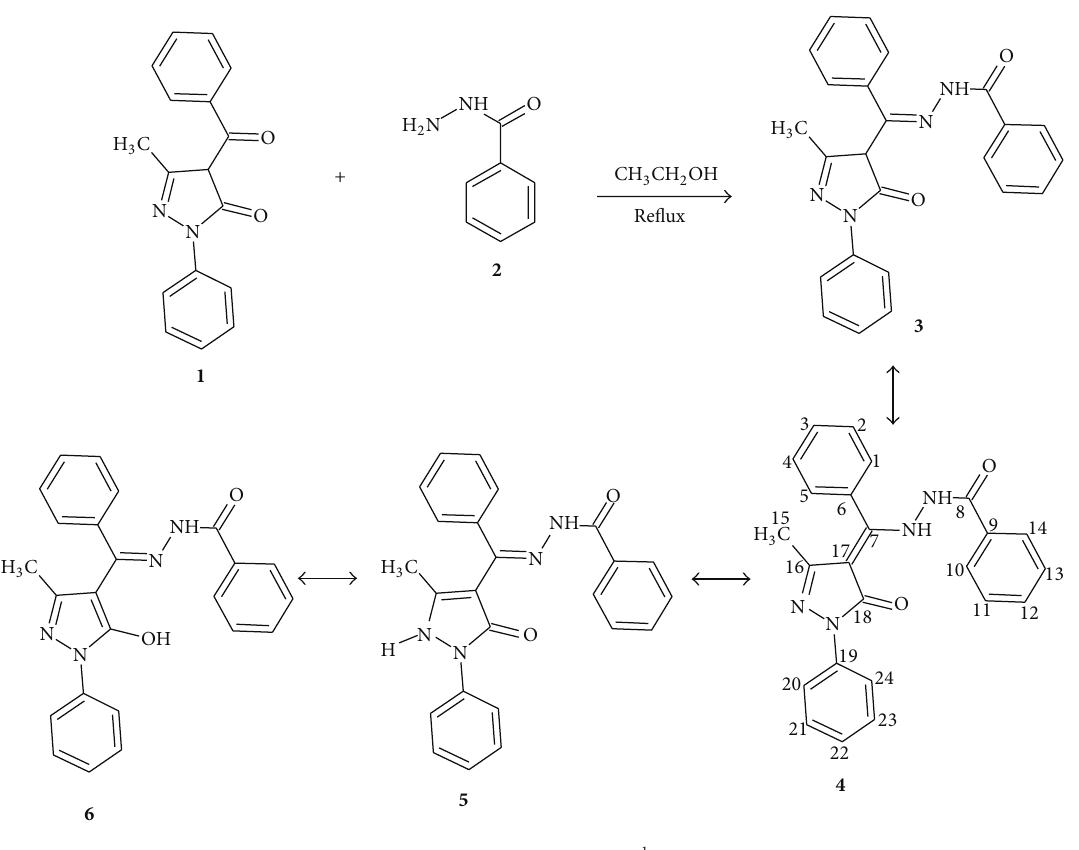
Figure 1: Synthesis of HL 1